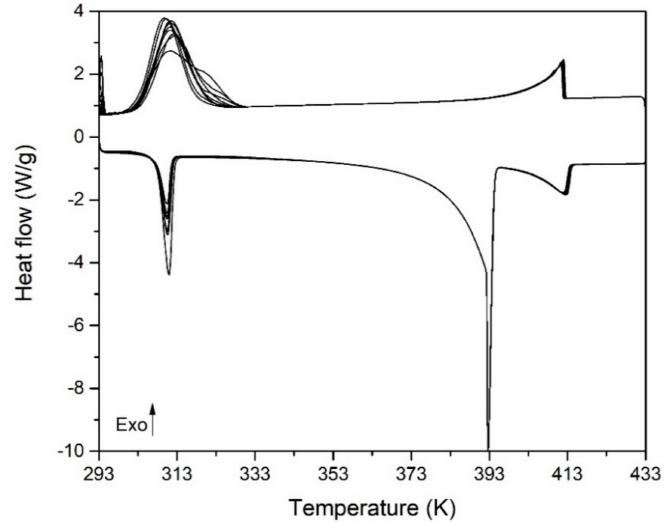
Figure 12. DSC thermograms obtained at heating / cooling rate of 1 K / min for NPG 0.515 TRIS 0.485 mixture with 10%wt. of